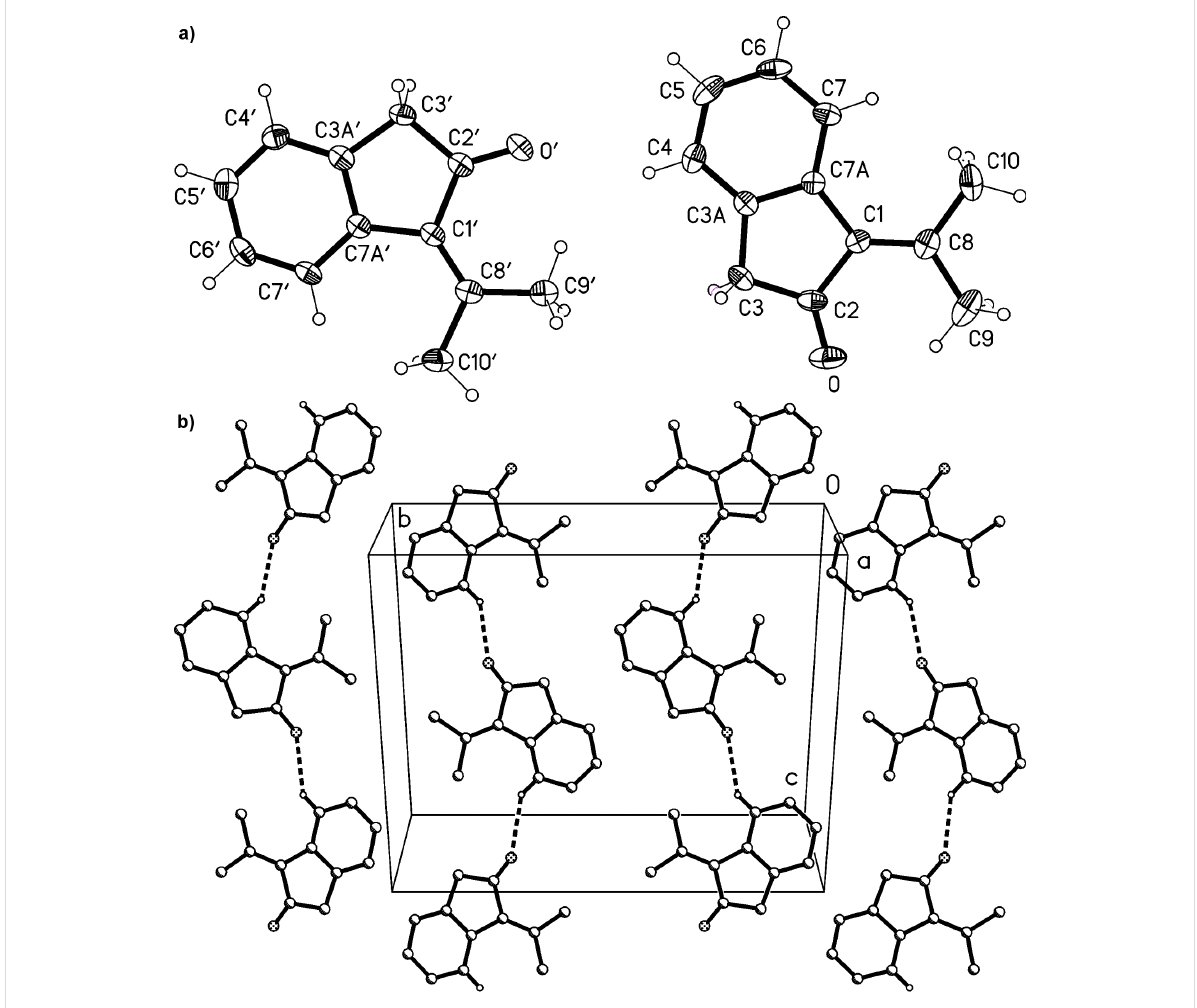
Figure 1: a) Both independent molecules of compound 13 in the crystal; ellipsoids represent 50% probability levels. b) Packing diagram of compound 13 (first independent molecule only) viewed perpendicular to ( ). Dotted lines indicate the weak hydrogen bond H7···O, 2.50 Å, which links the molecules to form chains parallel to [101]. Other H atoms are omitted for clarity. The layers of the second molecule (not shown) are not topologically equivalent; they do not contain an equivalent